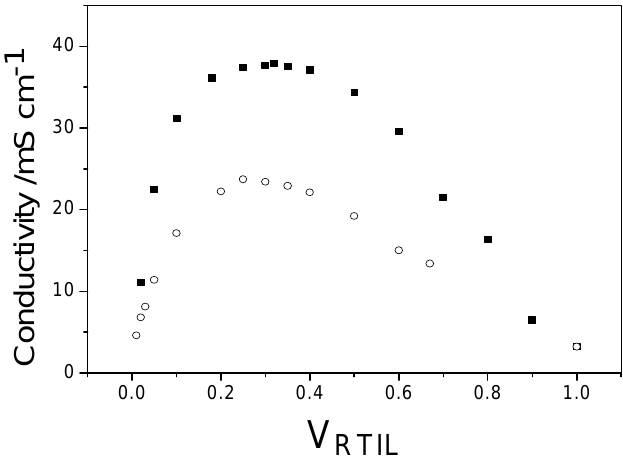
Figure 5. Electrical conductivity, σ vs. the volume fraction of [bmim][PF and RTIL/DMF （ ○ ）